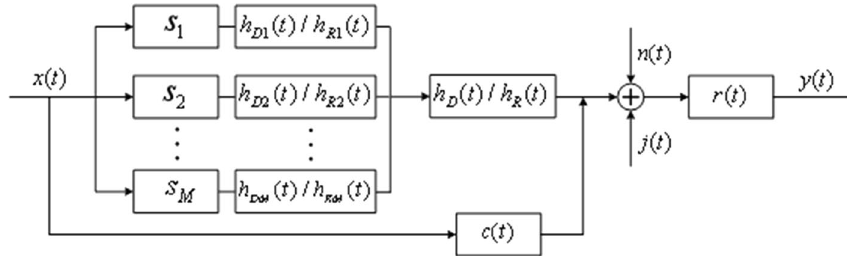
Fig. 3 Signal model for deterministic/random